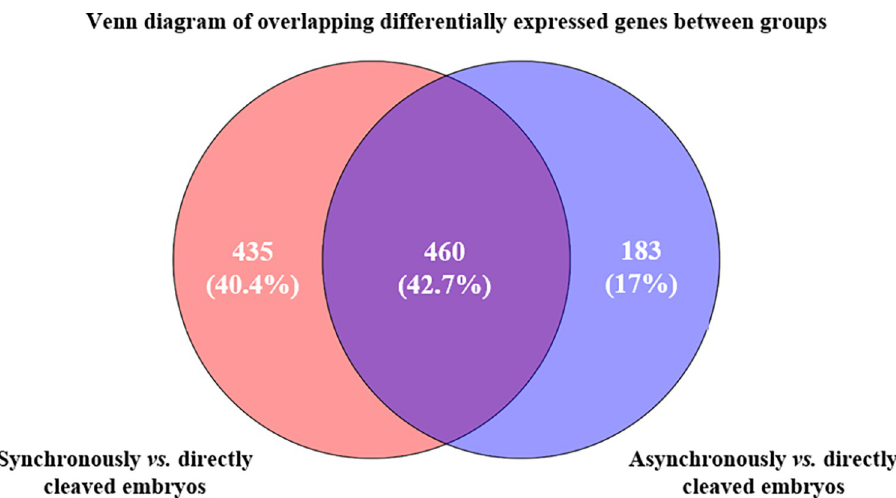
(blue, n = 183 genes); and overlapping genes in blastocysts from synchronously and asynchronously vs. directly cleaved embryos (purple, n = 460 genes).